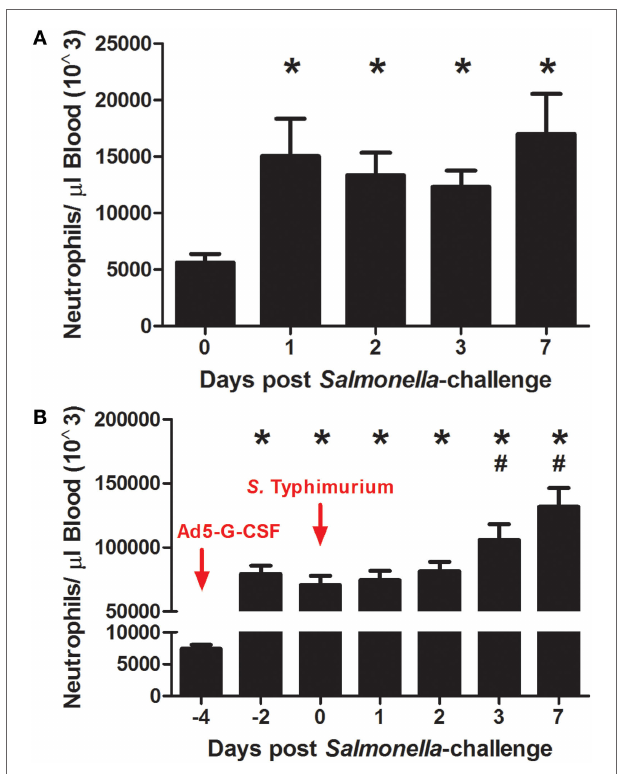
FigUre 1 | The number of circulating neutrophils following S . Typhimurium challenge and ad5-g-csF administration . Blood samples were collected at the noted day relative to Salmonella challenge for neutrophil enumeration by flow cytometry as described in Section “Materials and Methods.” Data are reported as the mean + SEM. (a) Pigs were intranasally challenged with 1 × 10 7 CFU of virulent S . Typhimurium UK1 strain ( n = 7). Significant difference ( P < 0.05) in circulating neutrophils relative to day 0 (*). (B) Pigs received a single intramuscular injection of Ad5-G-CSF followed by S. Typhimurium challenge with 1 × 10 7 CFU of S . Typhimurium UK1 ( n = 9). Significant difference ( P < 0.05) in circulating neutrophils relative to day − 4 (*) or day 0